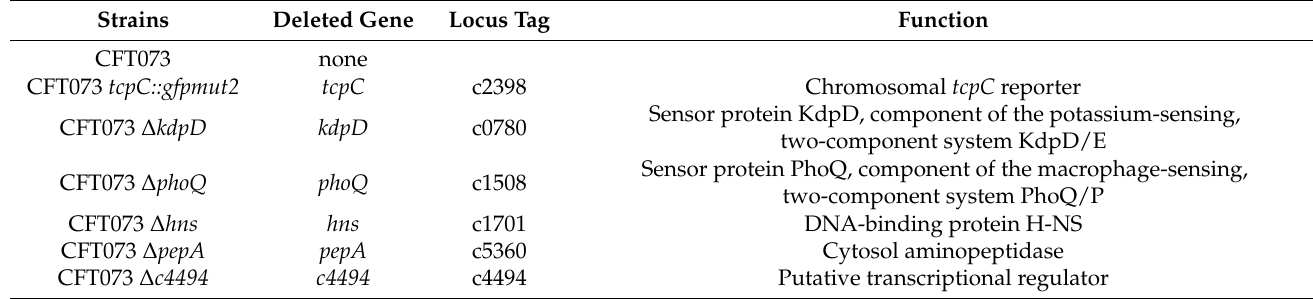
Figure 9. Strategy to generate gene-targeting cassettes. We used the primer pairs P a , P b (PCR 1) and P c , P d (PCR 2) to generate the “Giant” primers P 1 and P 2 which are homologous to the flanking regions of the target gene but also hybridize to the kanamycin cassette of pKD4. Using the primers P 1 and kan iR (PCR 3) or P 2 and kan iF (PCR 4) we amplified the 5 ′ and 3 ′ part of the kan-cassette. We then used the primers P a and P d (PCR 5) to fuse both parts and by that generating the complete gene targeting cassette. Primers P ef and P eR were used to verify the gene deficient mutant strains. Table 2. Bacterial